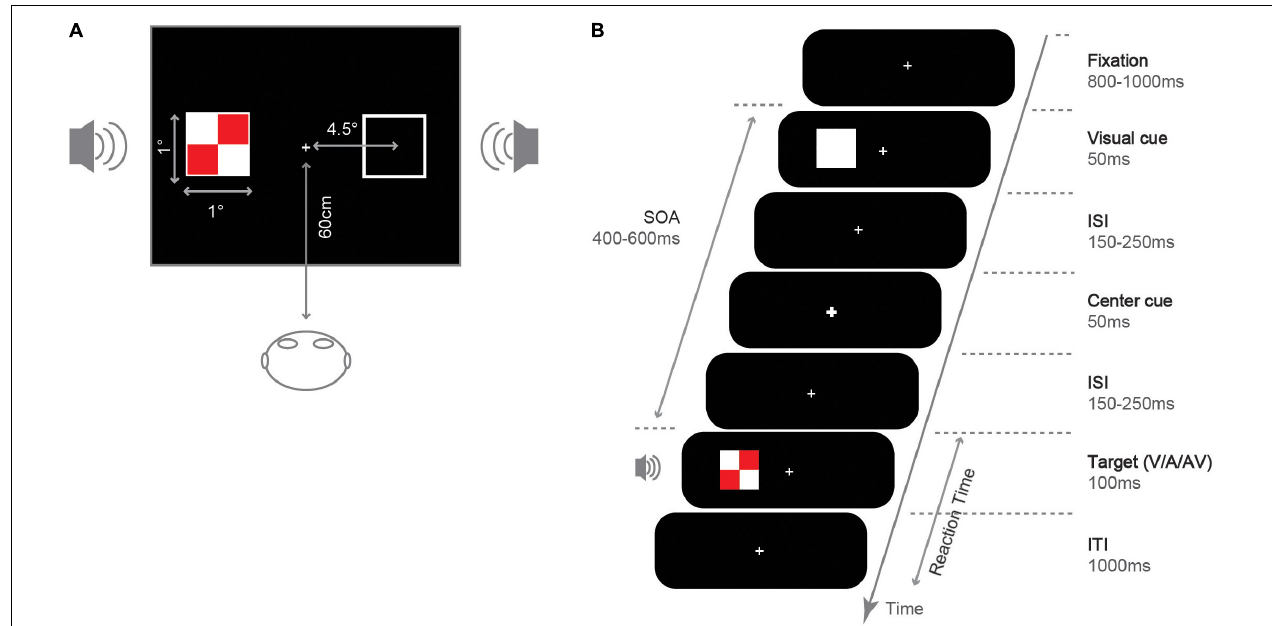
FIGURE 1 | Illustration for the stimuli and experiment. (A) Size and position. (B) Sequence of event and duration under the valid cue